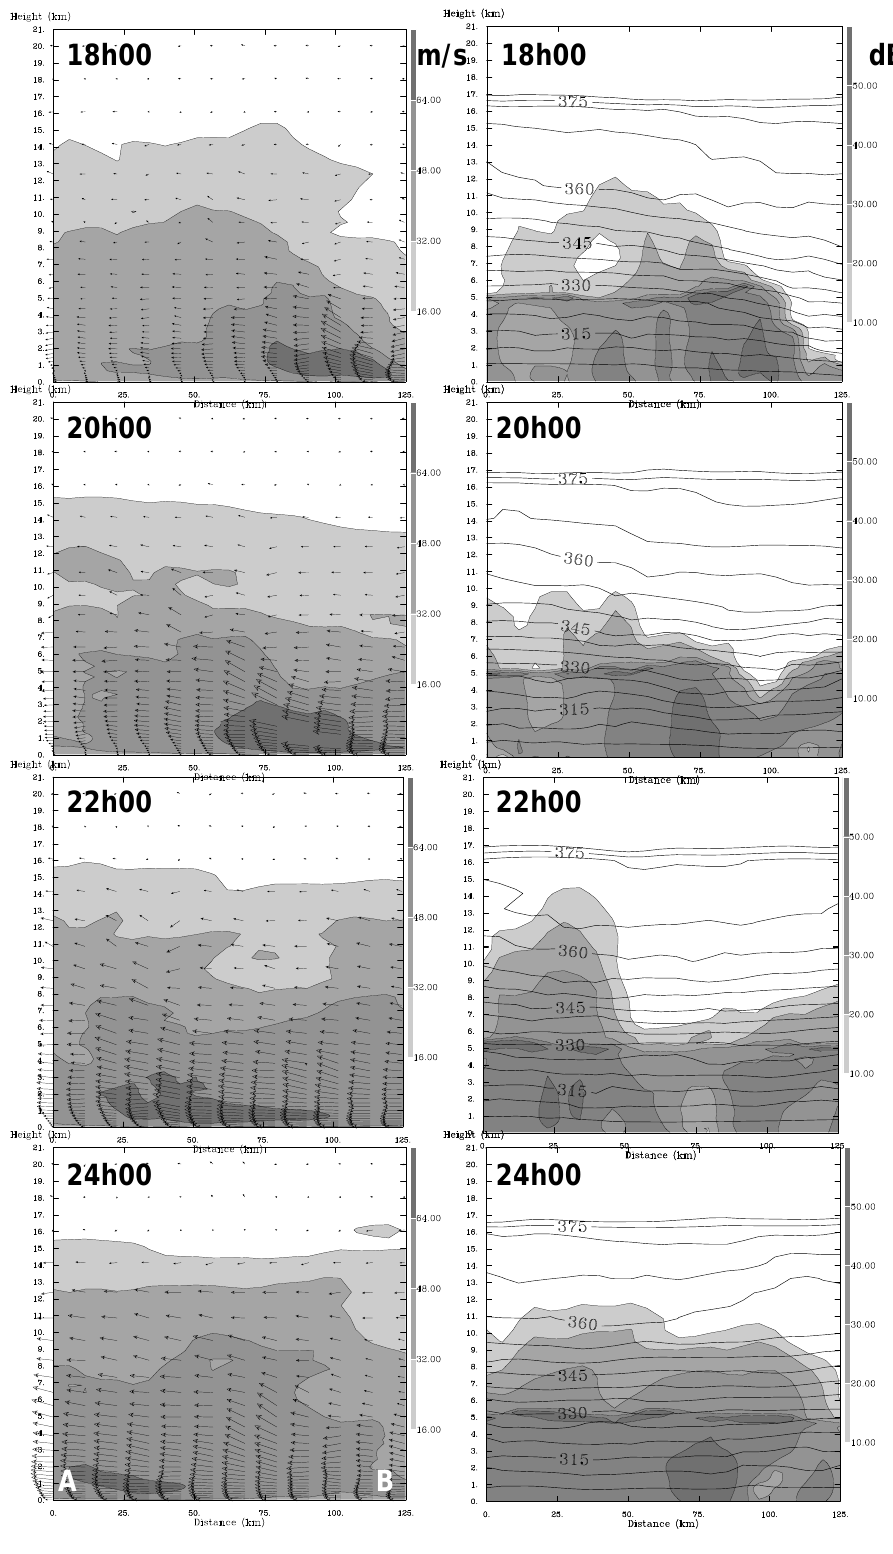
Fig. 10. Left panels: vertical cross-sections of horizontal wind speed (shaded, ms − 1 ) and wind vectors along line AB (see Fig. 9) in the 4-km model of experiment “ Ocean ”, every 2h from 18 to 24h ; right panels: as left panels, except for radar reflectivity (shaded, dBZ) and potential temperature (contours,